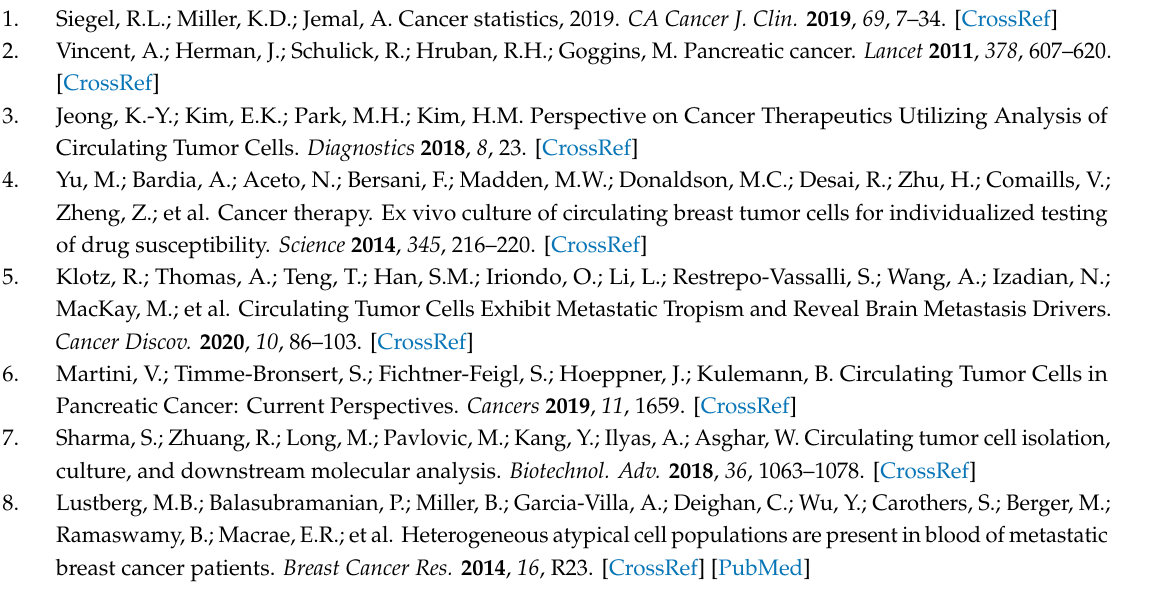
Figure S1: Visualization of the quality check metrics of 157 single-cell sequencing profiles; Figure S2: Expression of markers in peripheral blood mononuclear cells (PBMCs) from two healthy donors; Figure S3: Gas2l1 and Epcam expression do not correlate in murine pancreatic